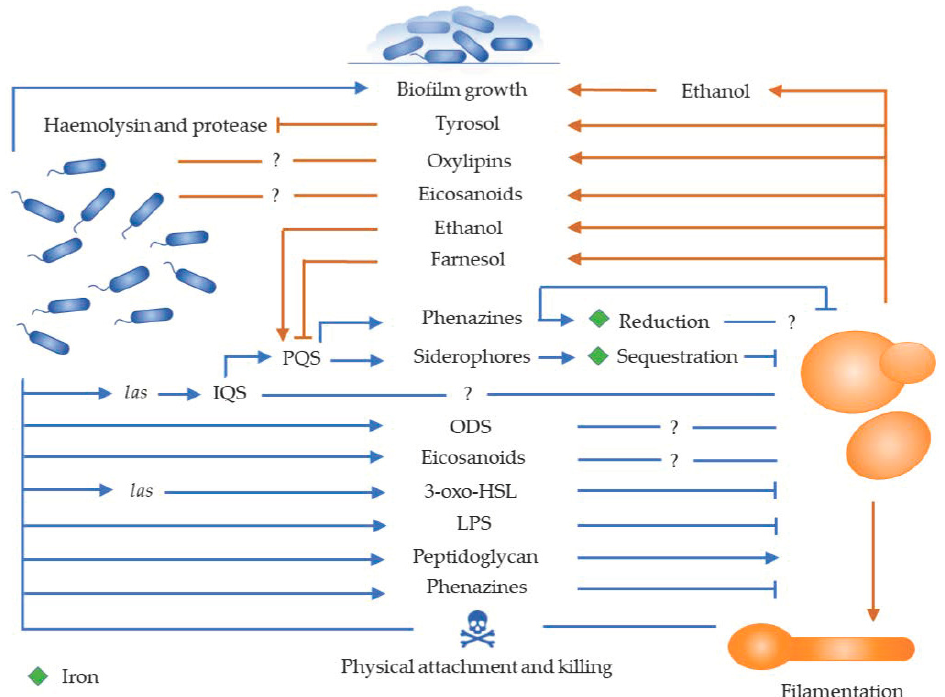
Figure 1. Schematic of the interaction between Candida albicans and Pseudomonas aeruginosa in vitro . P. aeruginosa kills C. albicans hyphae through physical attachment. In addition, cell wall